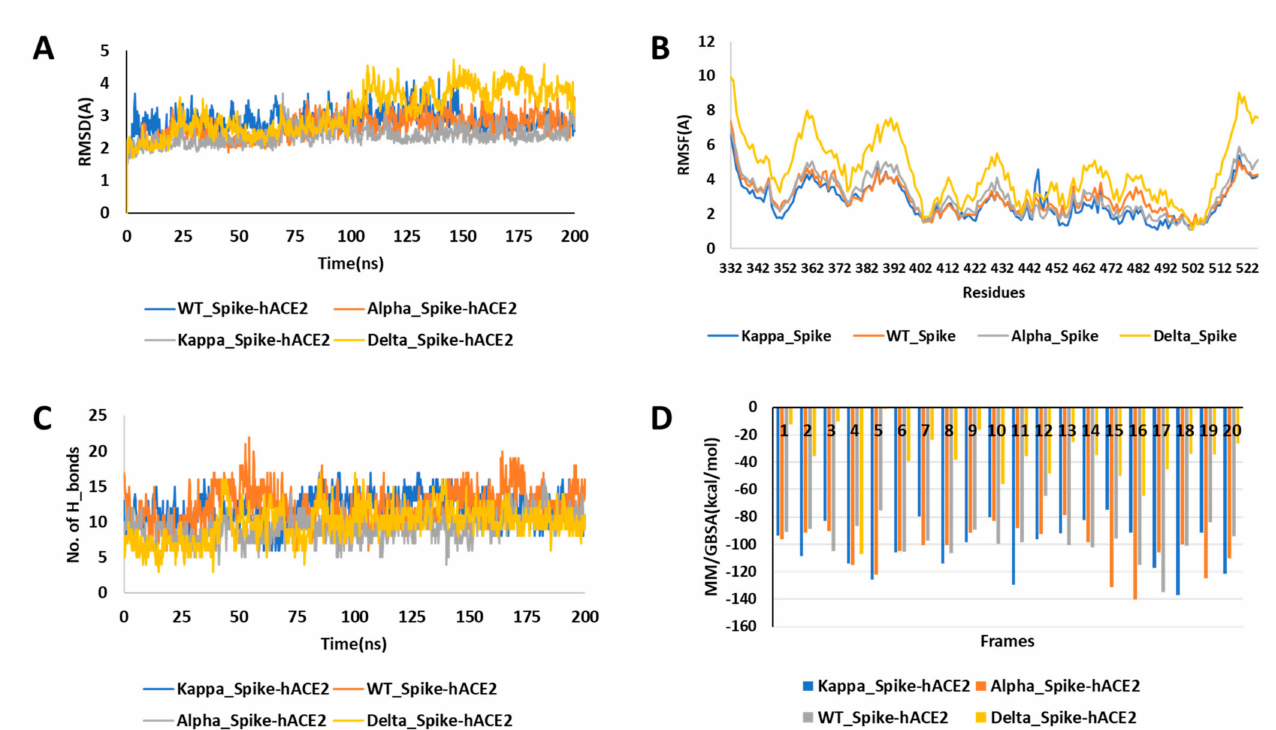
Figure 2. MD simulation analysis of the three simulated complexes. ( A ) RMSD plot showing similar deviation of all the simulated structures. ( B ) RMSF plot reveals that Residues 350-400 of the spike receptor binding domain (RBD) are more flexible, while the mutated residues have lesser fluctuation and are also comparable in all three structures. ( C ) The number of hydrogen bond count indicates that WT and Kappa variant have similar and higher number hydrogen bonds compared to Delta and Alpha variants. ( D ) MM/GBSA binding free energy of the 20 structure complexes extracted from each trajectory at equal span, suggesting that Kappa and Alpha spike variants have higher affinity for hACE2 in comparison to Delta and